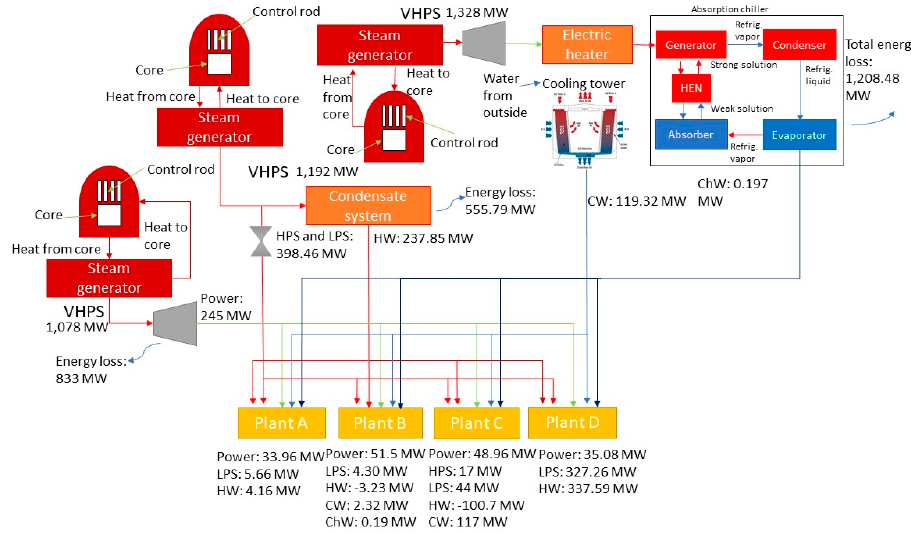
Figure 8. Final network for a conventional PWR that separately produces power, heating and cooling.